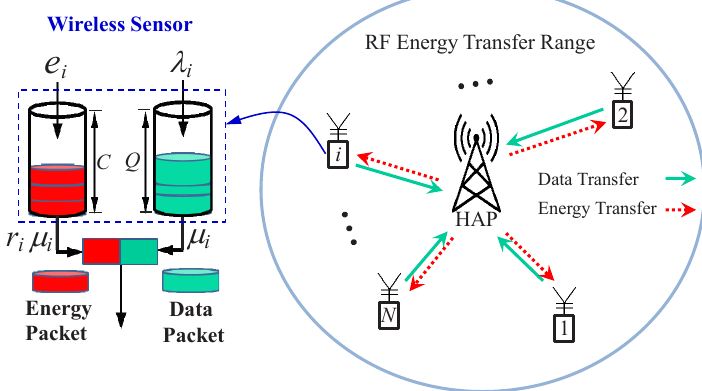
Figure 1. System model and queueing model of a wireless